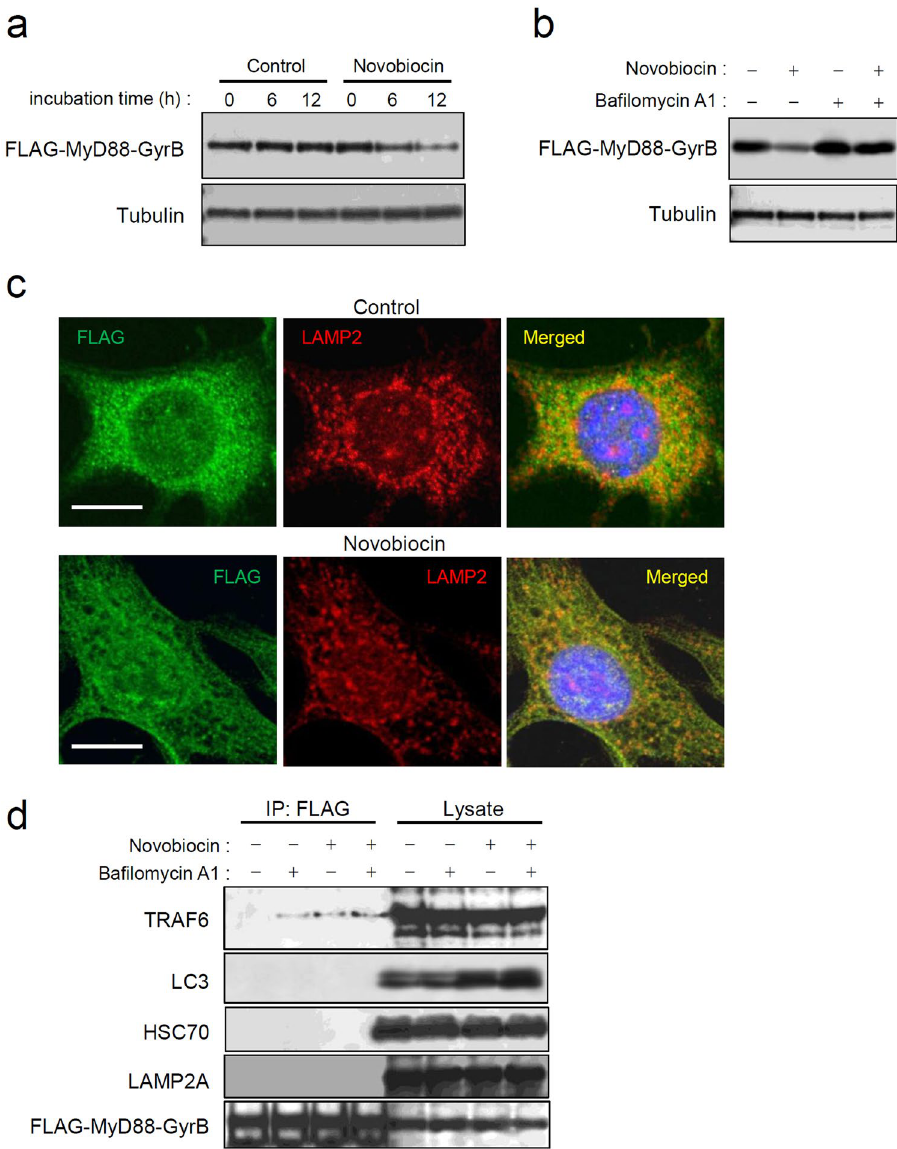
Figure 5. Monomeric MyD88 is targeted by basal autophagy. ( a ) Monomerization of MyD88-GyrB promotes its degradation. Myd88 − / − MEFs stably expressing FLAG-tagged MyD88-GyrB were incubated with 10 μ M novobiocin for the indicated periods, followed by cell lysis. Expression levels of FLAG-MyD88-GyrB and α -tubulin were assessed by immunoblotting. All the blots were obtained under the same experimental conditions, and the cropped images of the blots are shown. The uncropped images are in Supplementary Fig. 22. ( b ) Degradation of monomerized MyD88-GyrB is inhibited by lysosomal inhibition. Myd88 − / − MEFs stably expressing FLAG-tagged MyD88-GyrB were incubated with or without 10 μ M novobiocin for 12 h in the presence or absence of 100 nM BafA1. Expression levels of FLAG-MyD88-GyrB and α -tubulin were assessed by immunoblotting. All the blots were obtained under the same experimental conditions, and the cropped images of the blots are shown. ( c ) Speckles of MyD88-GyrB are downregulated by monomerization. Myd88 − / − MEFs stably expressing FLAG-tagged MyD88-GyrB were incubated with 0.5% DMSO or 10 μ M novobiocin for 12 h. Immunofluorescent staining of the cells for FLAG (green) and LAMP2 (red) was carried out, and cell nuclei were stained with Hoechst 33342. Images were obtained by confocal microscopy. Scale bar: 10 μ m. ( d ) Monomerized MyD88-GyrB interacts with TRAF6. Myd88 − / − MEFs stably expressing FLAG-tagged MyD88- GyrB were incubated with or without 10 μ M novobiocin for 12 h in the presence or absence of 100 nM BafA1, followed by cell lysis. Then immunoprecipitation (IP) using anti-FLAG-agarose was carried out with clarified lysates, followed by immunoblotting for TRAF6, p62/Sqstm1, LC3, ATG5, HSC70, LAMP2A, and FLAG- MyD88-GyrB. All the blots were obtained under the same experimental conditions, and the cropped images of the blots are